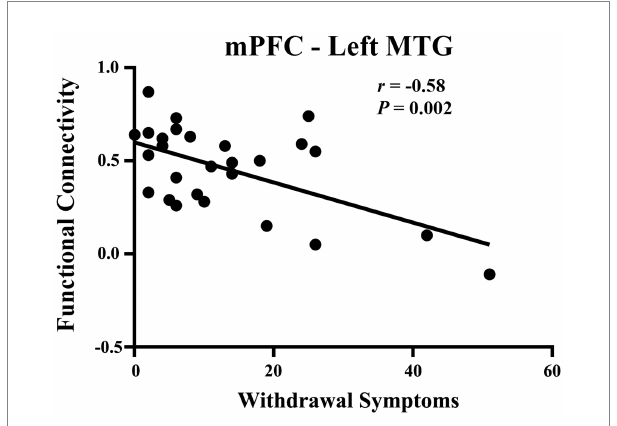
FIGURE 6 Correlation between withdrawal symptoms and functional connectivity of the mPFC-left MTG in the individuals with HUD after one-year